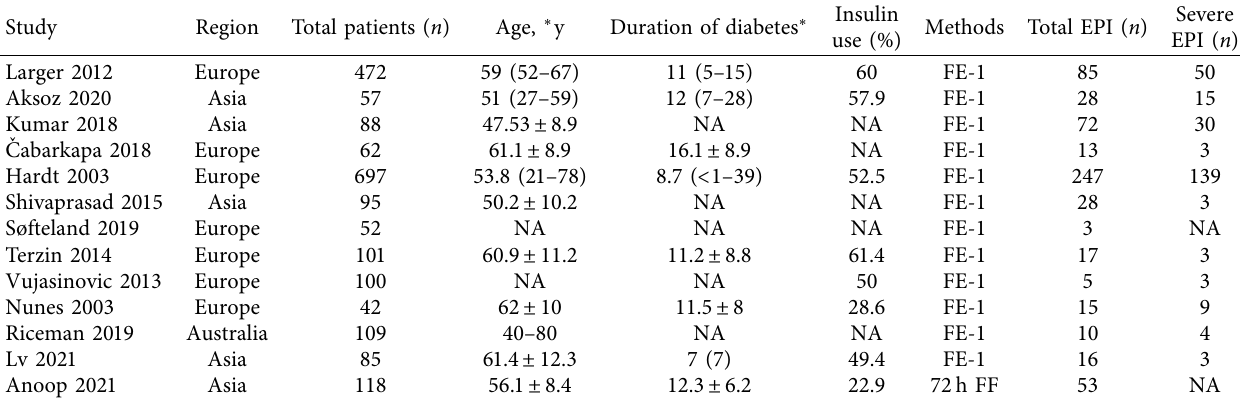
Table 1: Study and patient characteristics of the included